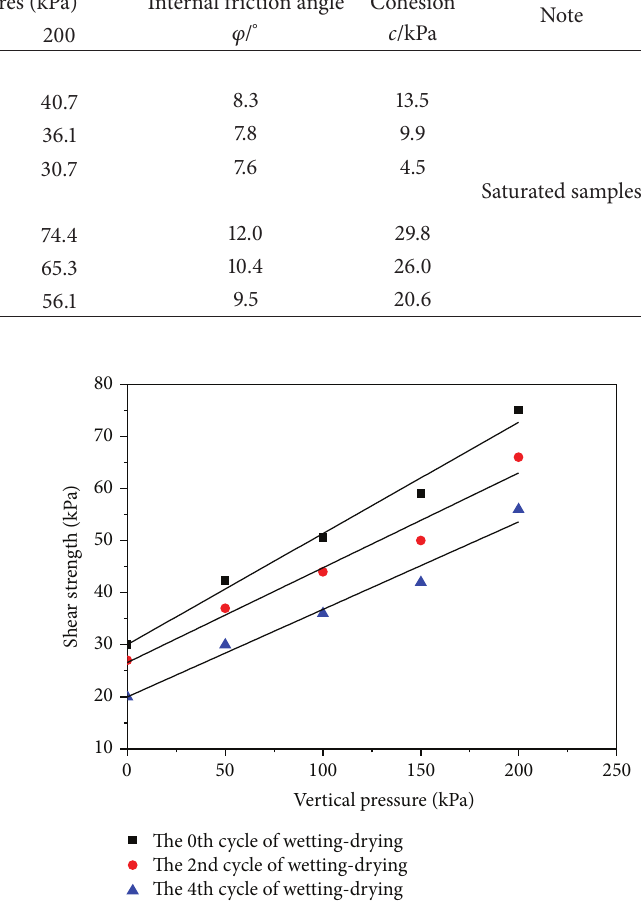
Figure 5: Shear strength of improved soil during wetting-drying cycles.